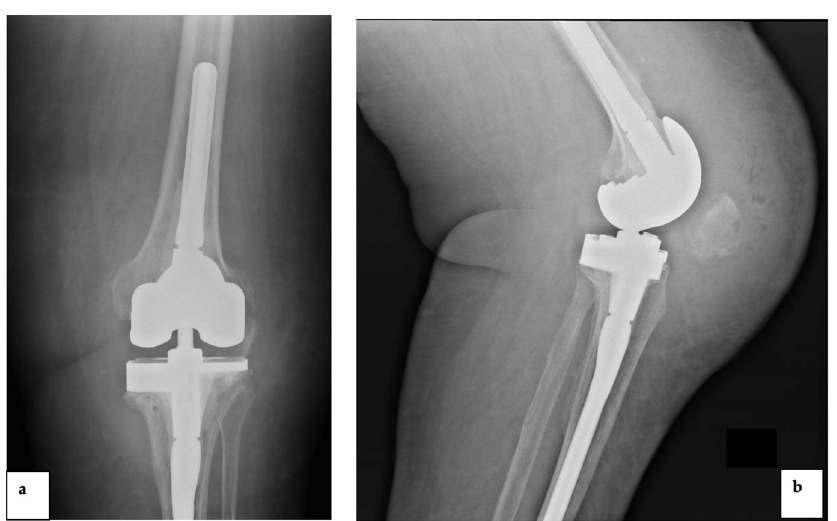
Figure 1. The plain radiograph showed periprosthetic infection of the condylar constrained knee implant due to Staphylococcus warneri (( a ): anteroposterior view and ( b ): lateral view). Thirty days later, the patient referred to our institution due to persistence of pain and empiric intravenous antibiotic therapy was started with 1 g vancomycin two times daily,